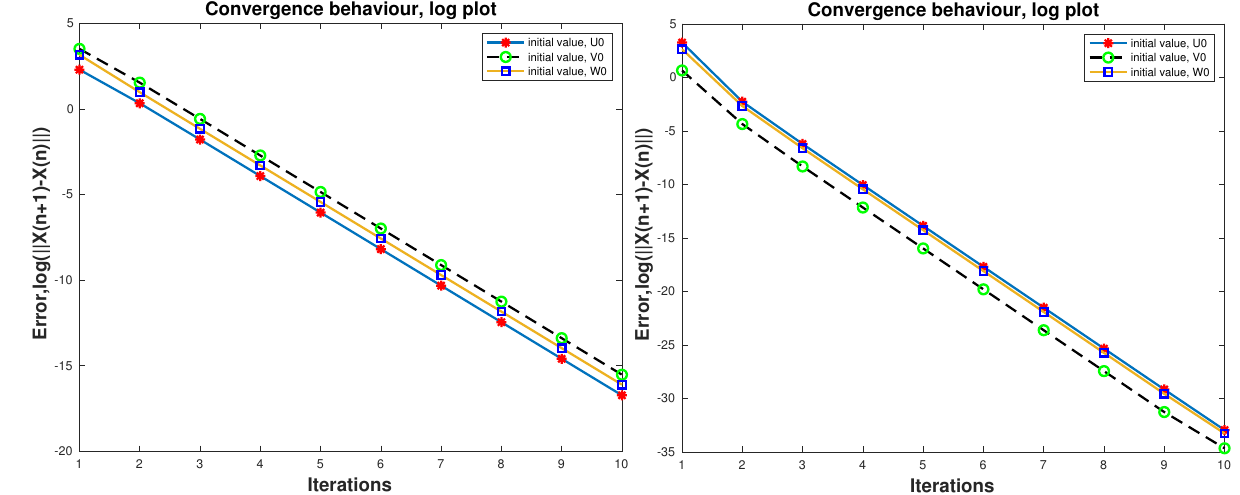
Figure 2. Convergence behavior for b = 0 ( left ) and b = 30 ( right